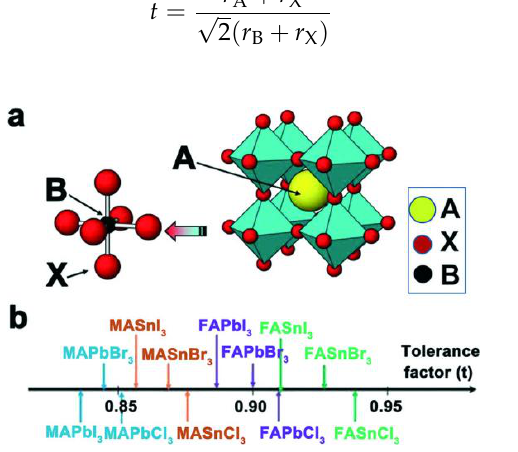
Figure 1. ( a ) Unit cell of ABX 3 with octahedral structure; ( b ) the tolerance factor of different crystal structures. Image is reproduced from Reference [24] with permission. structures. Image is reproduced from Reference [24] with